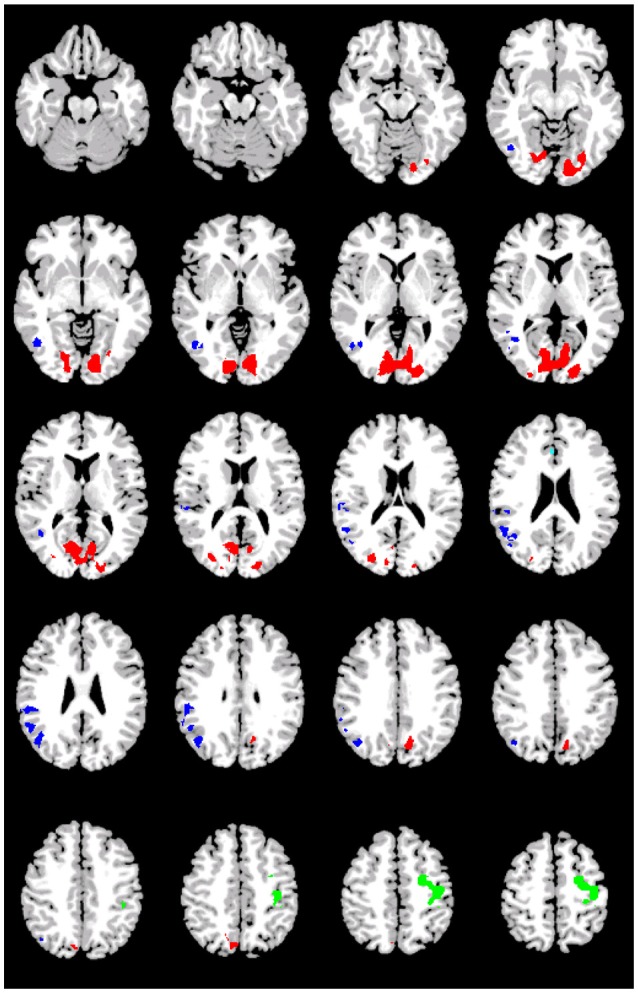
Preferential activations for the conjunction of GAP-completion subtractions. Images are shown corrected at p < 0.05 in radiological format (LH is on the right). Green: BA6, primary motor and primary sensory connected with anterior cinculate (Acqua); Red: BA7, BA19, primary and association visual; Blue: right visual (association), right angular/supramarginal gyri, and fusiform.